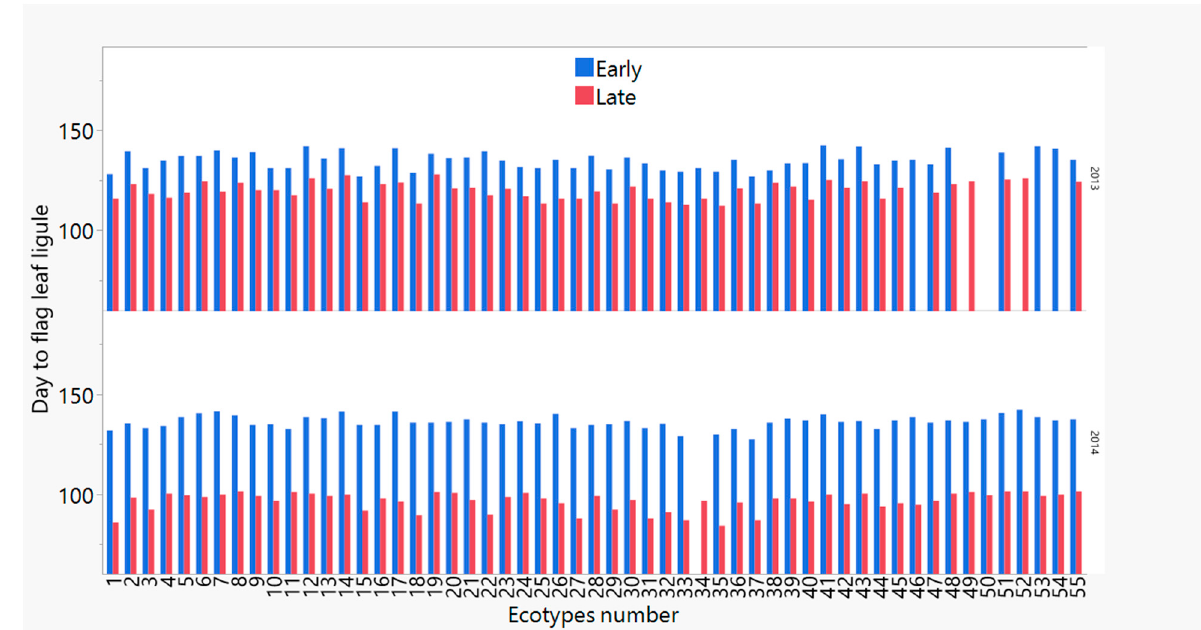
Figure 4. Duration of vegetative phase as a ff ected by di ff erent sowing dates for Chadian dry-season sorghum accessions, grown at the Youé research farms in Chad in 2013 and 2014.